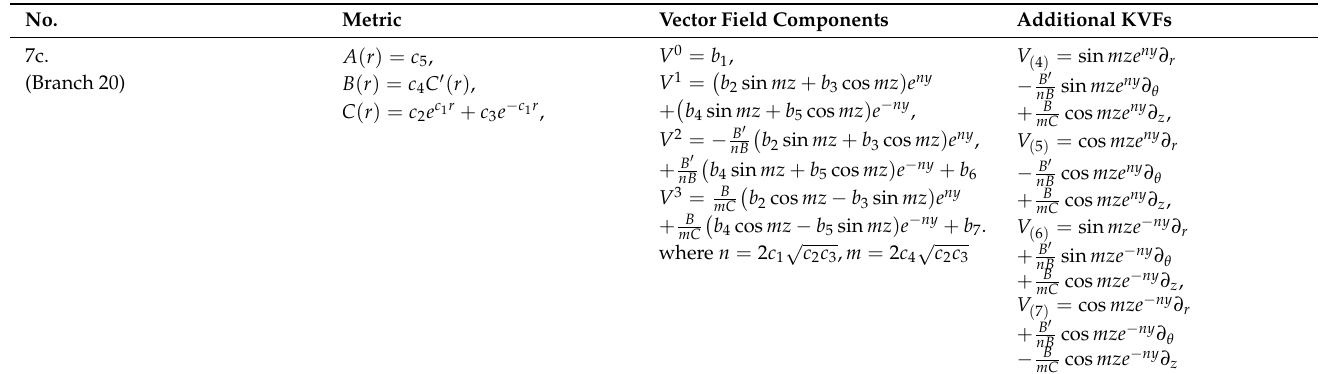
Table 5. Metrics admitting seven